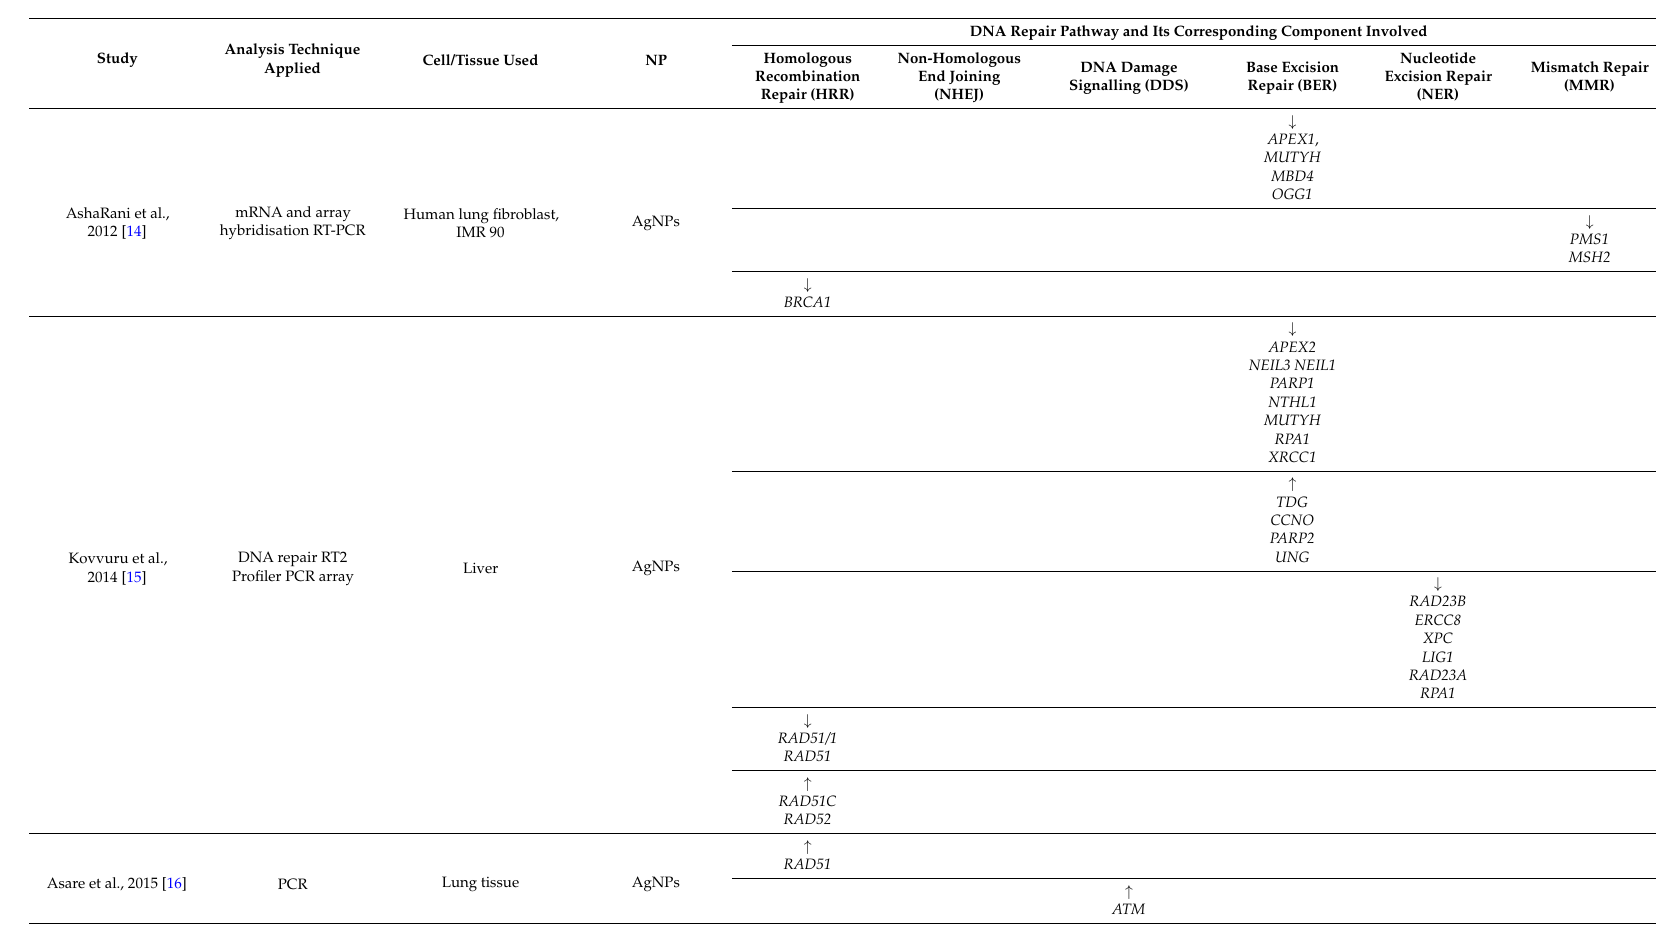
Table 1. Summary of studies showing ENMs-induced changes in components of DNA repair pathway. The arrow indicates upregulation or downregulation of the specified molecule at either the gene/protein level or enzymatic activity, depending on the analytical technique